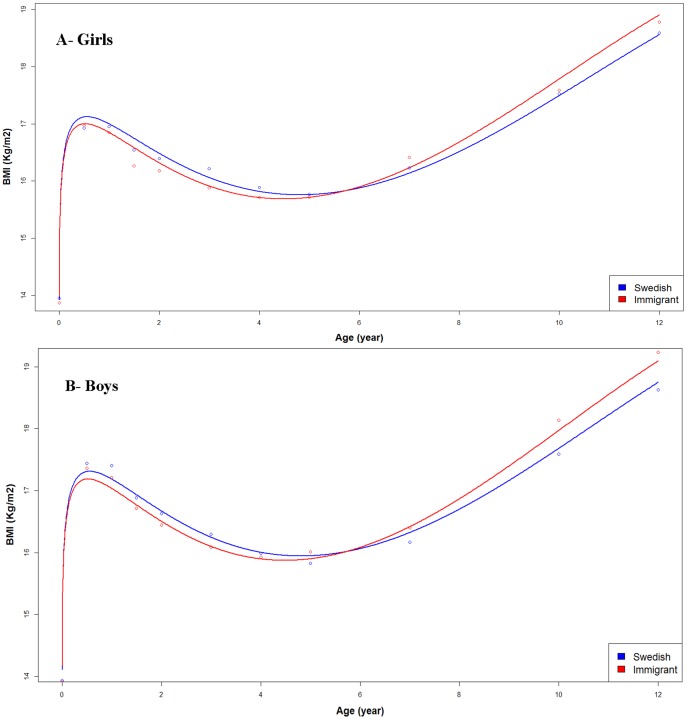
Estimated body mass index (BMI) from birth to 12 years, adjusted for maternal and perinatal characteristics by maternal migration status in girls (A) and boys (B) born between 1994 and 1996 in Stockholm.* Circles represent crude mean BMI.